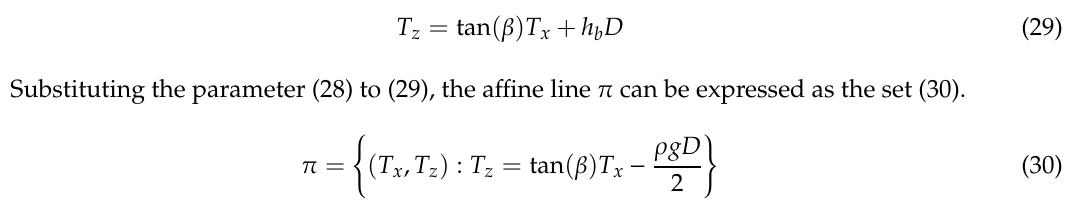
β h with given ς . and b